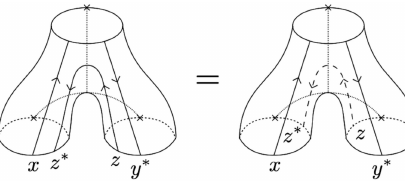
. The same holds for g ∈ Hom( y, y 0 ) . xy